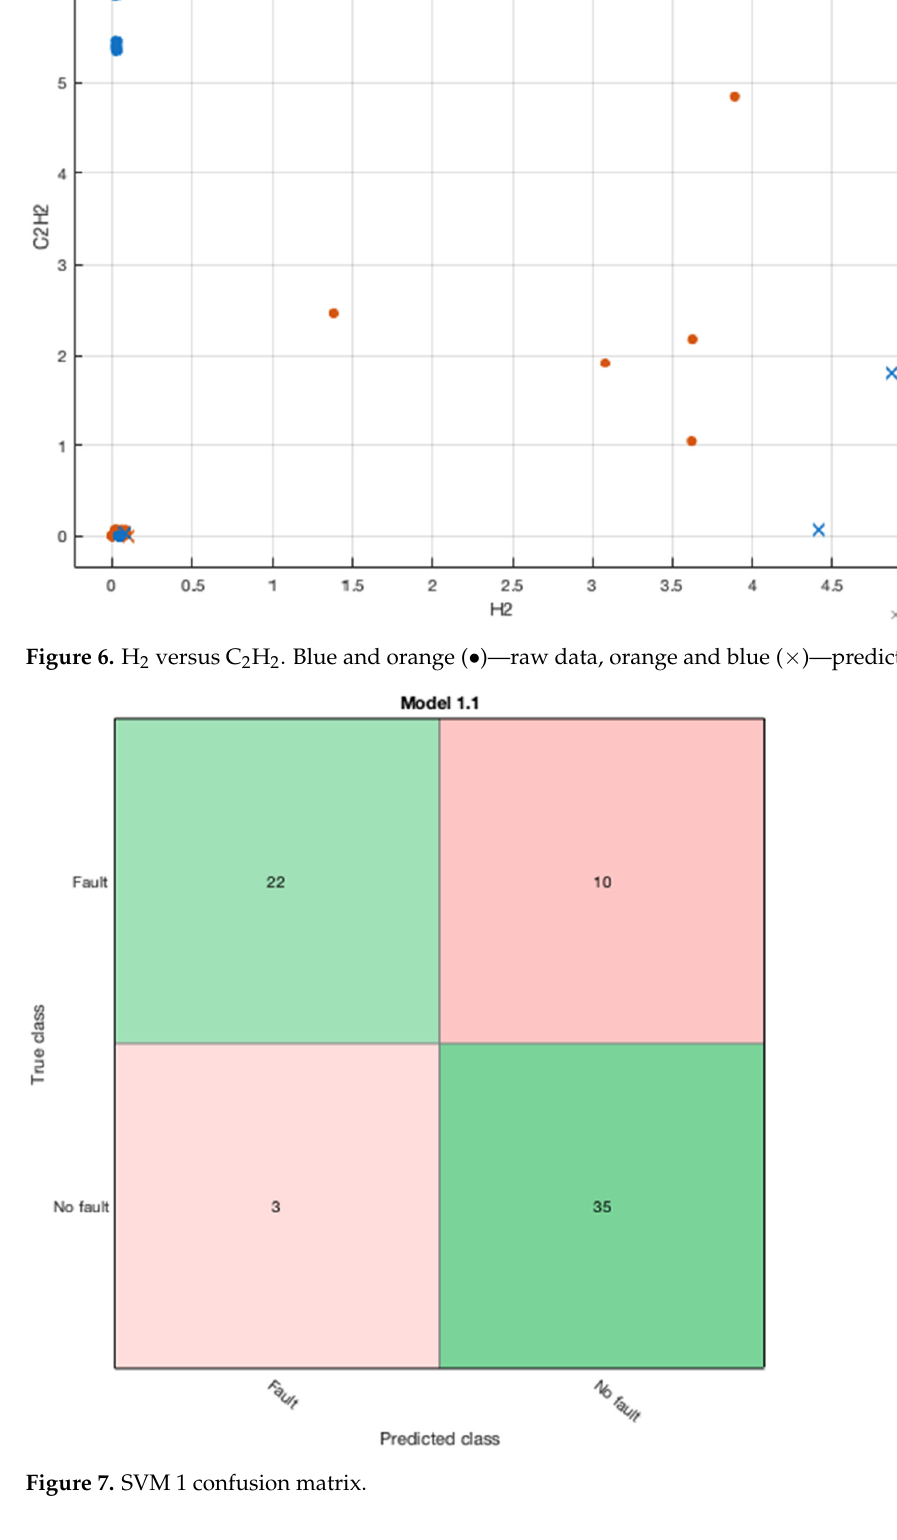
Figure 7. SVM 1 confusion